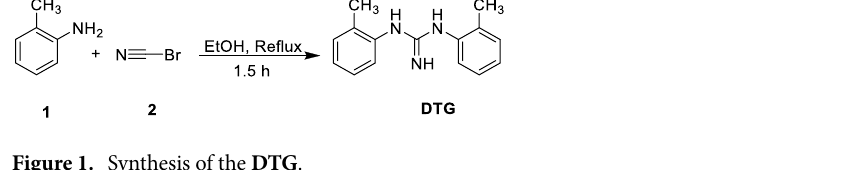
Figure 1. Synthesis of the DTG